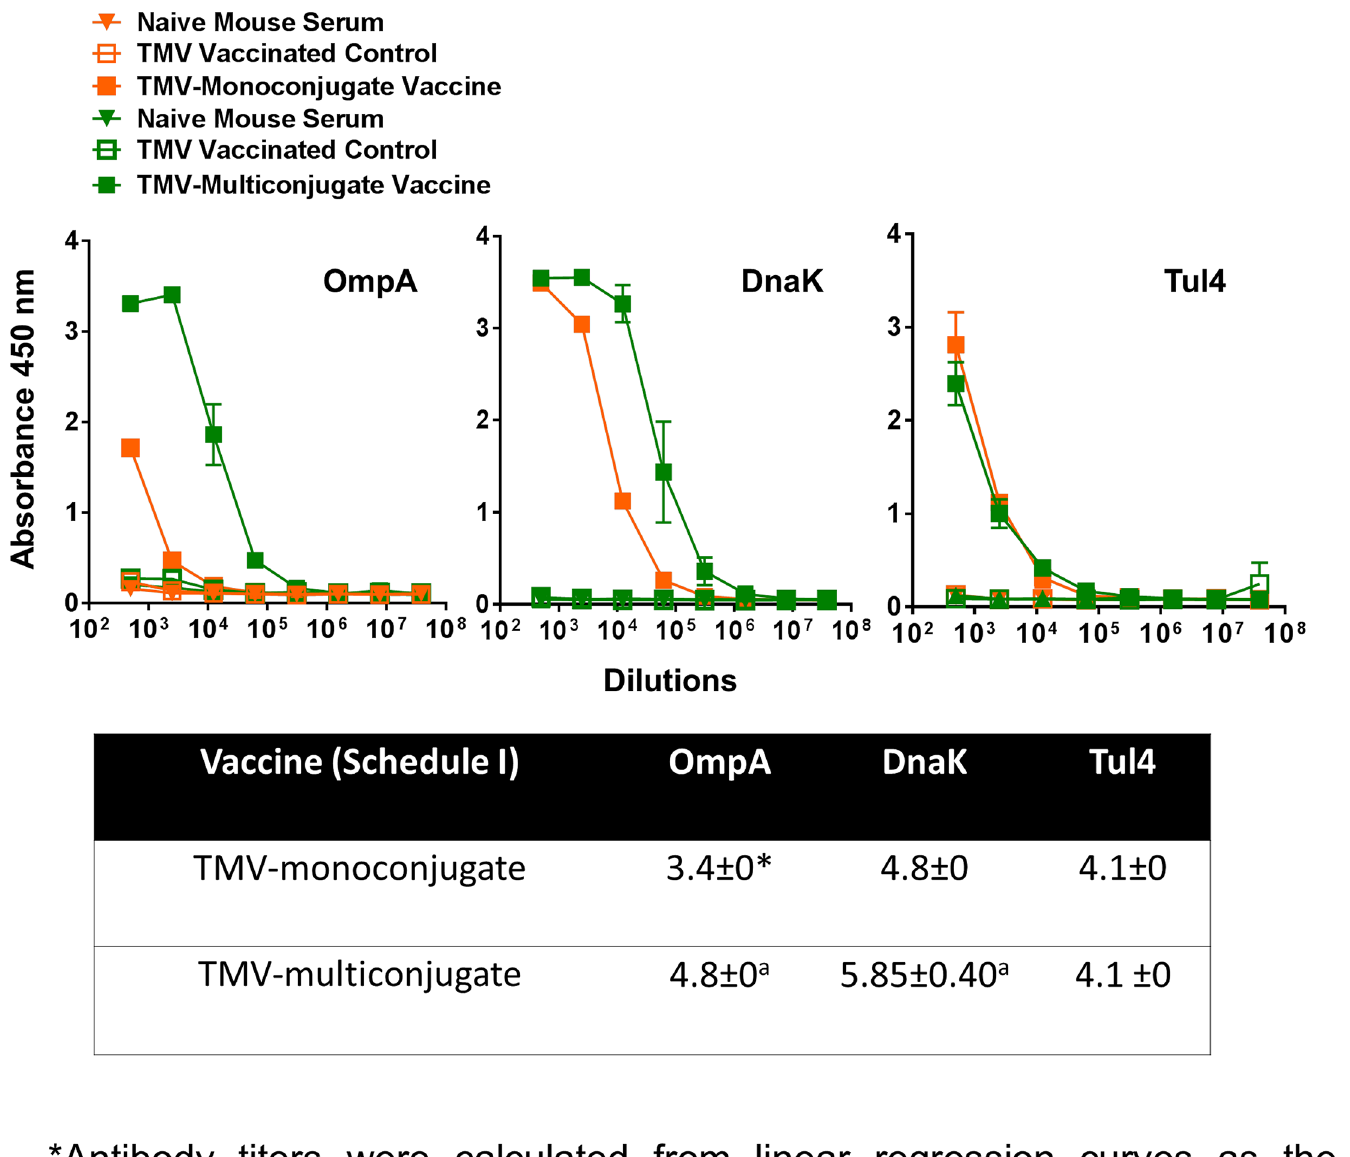
Fig 7. OmpA, DnaK and Tul4 Specific Antibody Responses in Mice Immunized with TMV-Monoconjugate and TMV-Multiconjugate Vaccines using Schedule I of Immunization. F . tularensis SchuS4 recombinant proteins OmpA, DnaK and Tul4 specific IgG antibody levels on day 28 in serum samples of C57BL/6 mice immunized with TMV-monoconjugate and TMV-multiconjugate vaccine using Schedule I were determined by ELISA. Serum samples obtained from na ï ve mice or those inoculated with TMV alone were used as controls. The data are represented as Mean ± S.D. of absorbance values measured at 450nm. Table shows comparison of antibody titers between groups of mice vaccinated with these vaccine formulations.